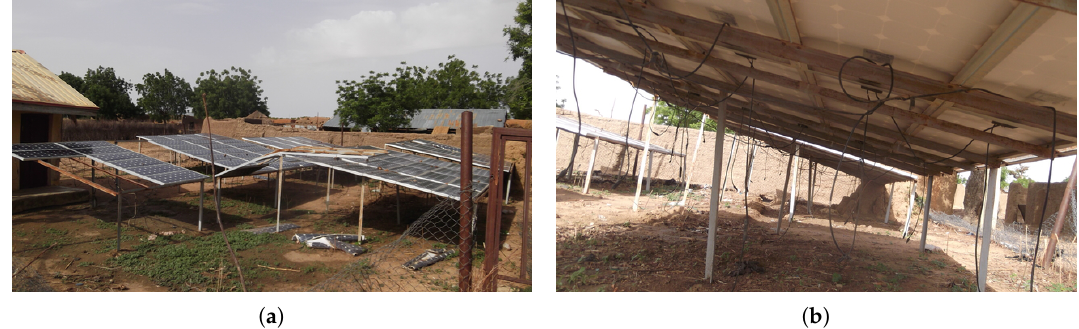
Figure 3. An example of failed 10 kW solar microgrid [131]: ( a ) The front view of the solar PV modules; ( b ) The back view of the solar PV